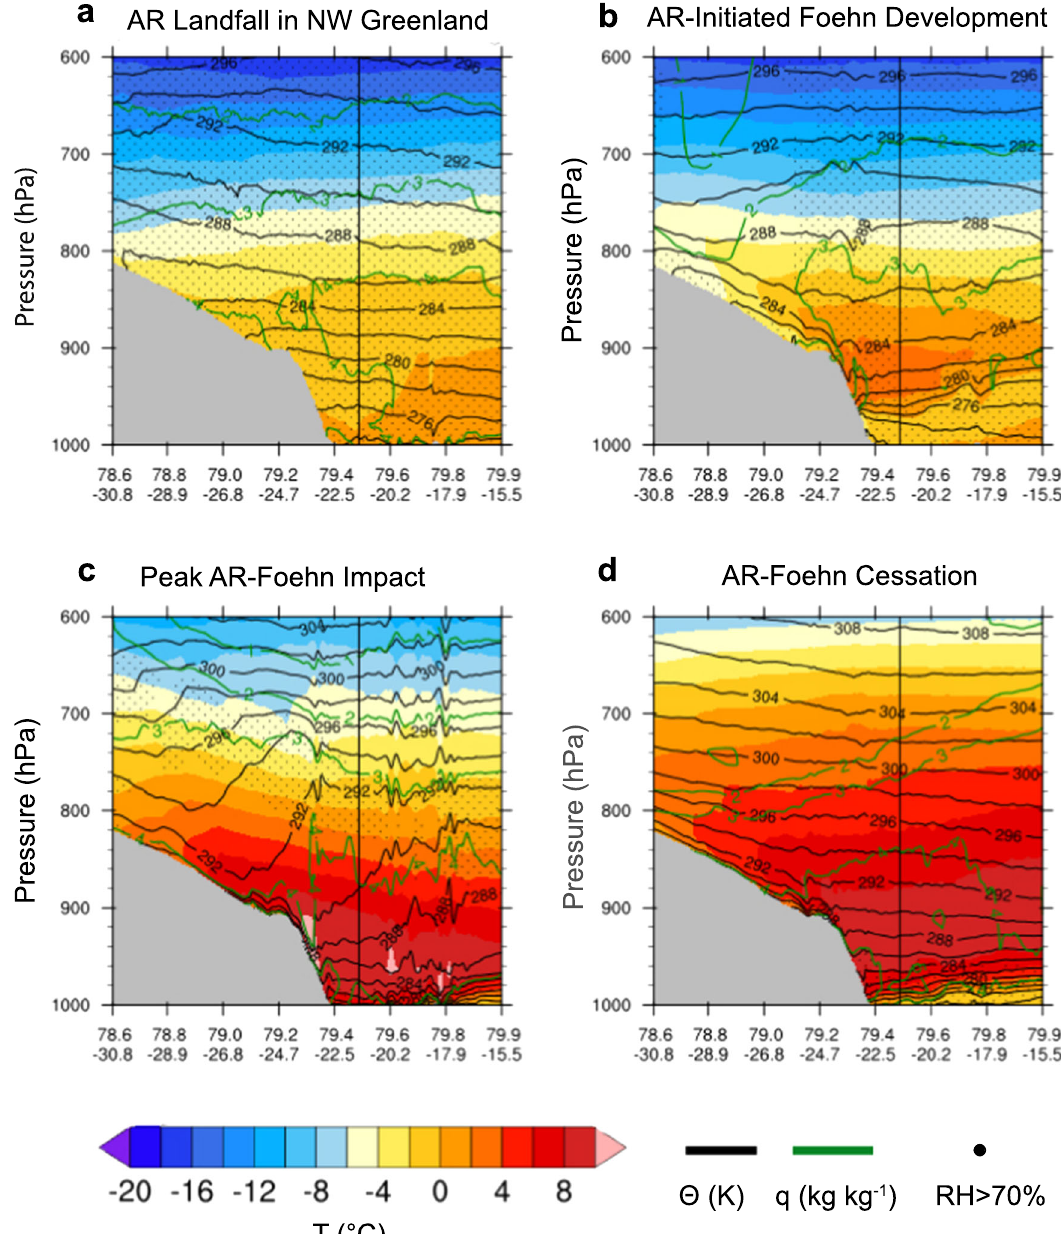
Fig. 4 | Atmospheric cross sections of the July 2014 atmospheric river (AR)- foehn event over the 79°N Glacier region of northeast (NE) Greenland. Cross sections are derived from Polar Weather Research and Forecasting (Polar WRF) modelsimulationsandcoverthetransectshownbytheblackdashedlineinFig.1b. The colored contoursrepresent air temperature( T ),black linesshowthepotential temperature ( θ ), and green contours are the speci fi c humidity ( q ). Relative